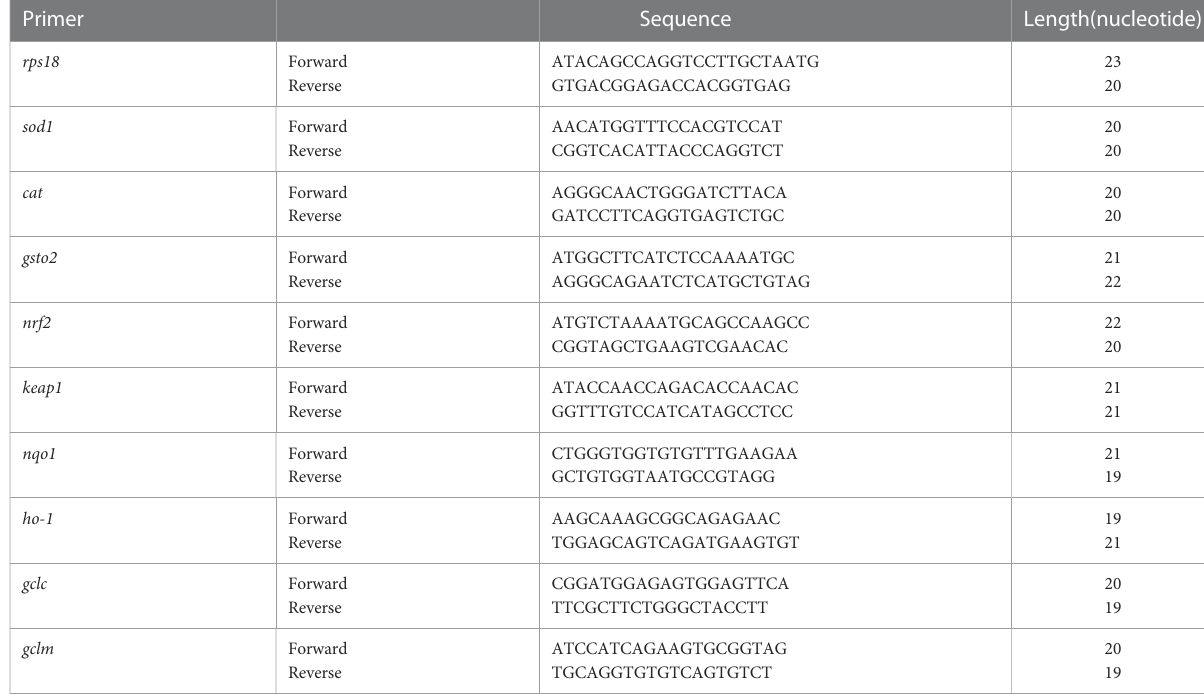
TABLE 1 The gene primers for quantitative real-time PCR. Primer Sequence